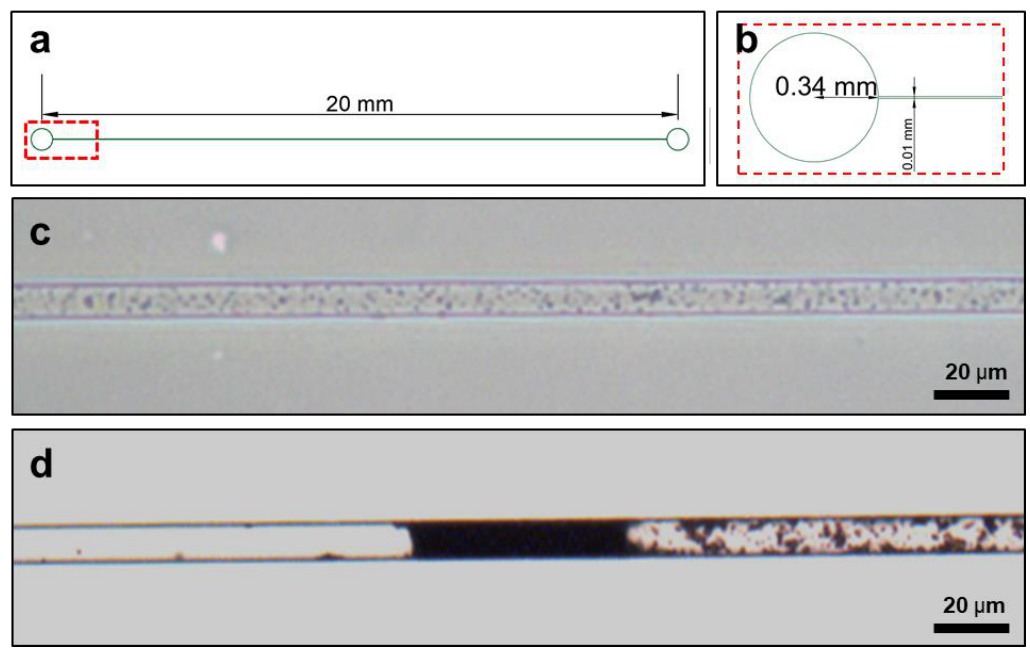
Figure 6. LM/DSPC/DOX particles tested on microfluidic chips as an embolism model. ( a , b ) The Figure 6. LM / DSPC / DOX particles tested on microfluidic chips as an embolism model. ( a , b ) The design of the PDMS microfluidic chip. ( c ) Fluid containing LM/DSPC/DOX particles in a micro design of the PDMS microfluidic chip. ( c ) Fluid containing LM / DSPC / DOX particles in a micro channel. channel. ( d ) Blocking the micro channel with heat induced transformation of LM/DSPC/DOX particles. ( d ) Blocking the micro channel with heat induced transformation of LM / DSPC / DOX